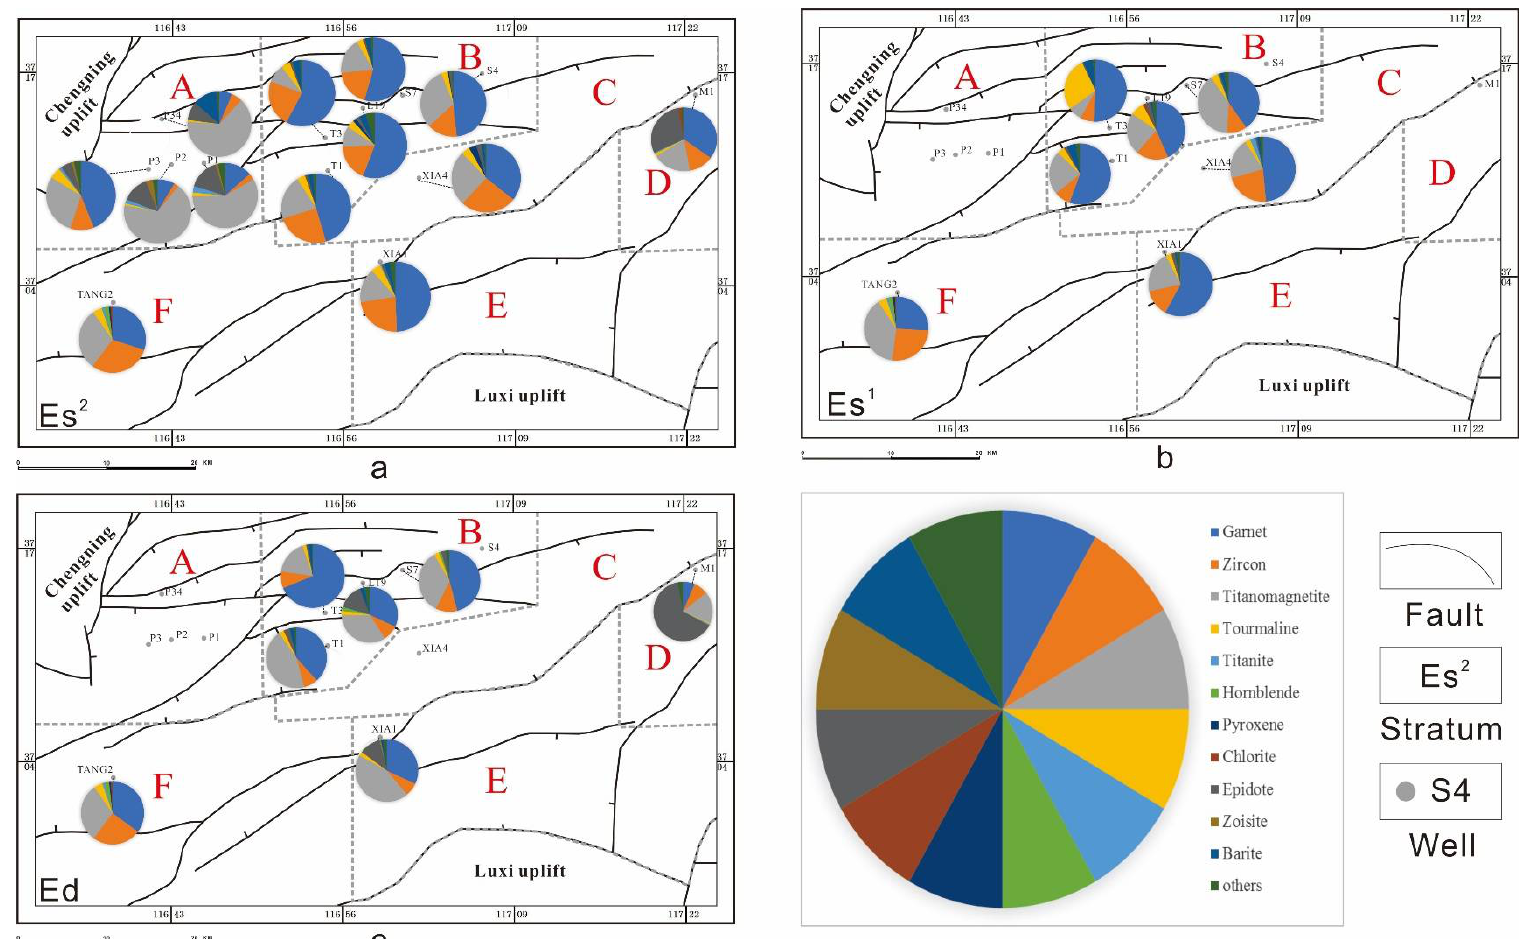
Figure 7. Characteristic planar distribution map of the heavy mineral assemblages of the Huimin depression. ( a ) Distribution of the heavy mineral assemblage of the Es 2 . ( b ) Distribution of the heavy mineral assemblage of the Es 1 . ( c ) Distribution of the heavy mineral assemblage of Ed. Based on the characteristics of its heavy mineral assemblage, the Huimin depression can be divided into six sedimentary areas: A, B, C, D, E, and F.